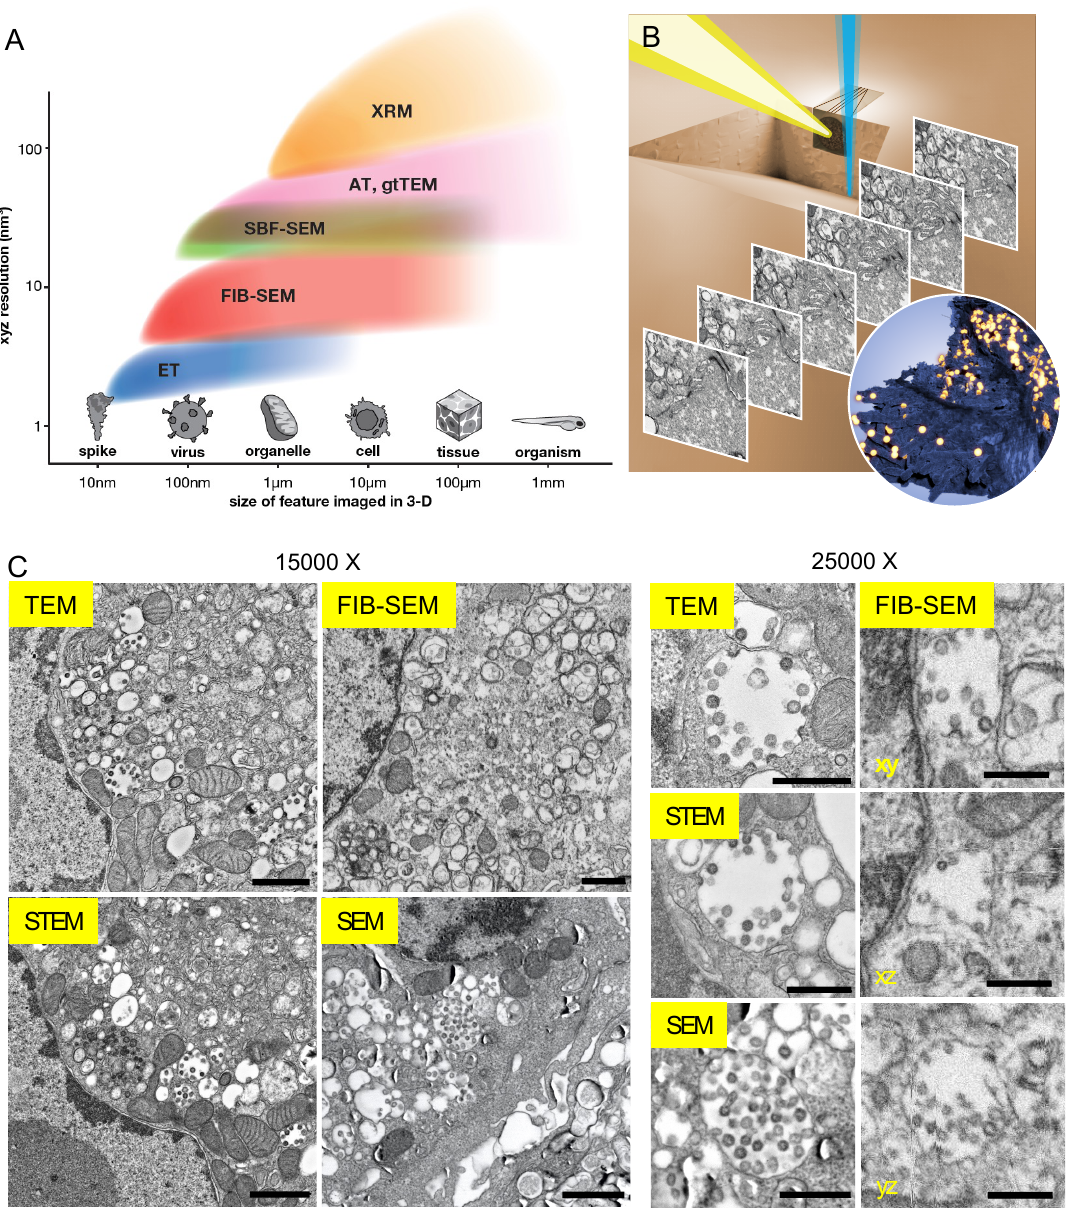
Figure 1. Focused ion beam scanning electron microscopy (FIB-SEM) versus other electron microscopy (EM) approaches in imaging viruses and cells. ( A ) FIB-SEM occupies a crucial gap in a plot of typical resolutions achieved against the size of volumes imaged by volume EM (vEM) techniques. XRM: X-ray microscopy, AT: array tomography, gtTEM: grid-tape TEM, SBF-SEM: serial block face SEM, FIB-SEM: focused ion beam SEM, ET: electron tomography. ( B ) Schematic of FIB-SEM acquisition. Iterative gallium ion milling (blue beam) and scanning electron imaging (yellow beam) produce serial micrographs, which are aligned and segmented to reveal features such as infected cell membranes (dark blue) and viral particles (yellow spheres). ( C ) Representative images of SARS-CoV-2 infected Vero E6 cells taken by different EM imaging modalities. Images were acquired at ~15,000 × (left) or ~25,000 × (right) magnifications. TEM: transmission electron microscopy, STEM: scanning transmission electron microscopy, FIB-SEM xy, xz, yz: representative slices from orthogonal planes of the reconstructed volume. The raw FIB-SEM and SEM images were contrast inverted to match TEM and STEM micrographs visually. Scale bars: 1 µ m (left), 500 nm